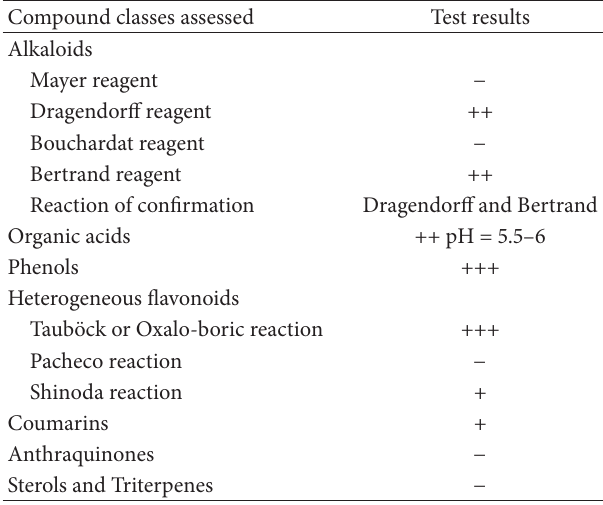
Table 3: Tests for the 70% hydroethanolic extract of the fruit Solanum sessiliflorum Dunal.